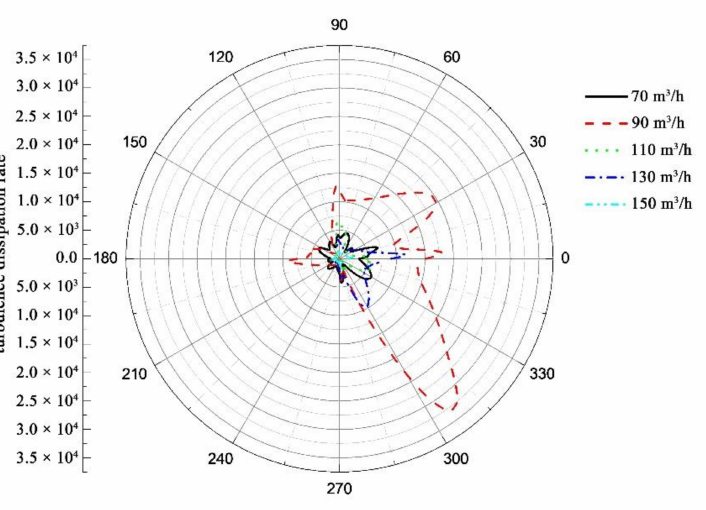
Figure 20. The variation rule of the circumferential turbulence dissipation rate at the outlet section shroud within the first impeller under different flow